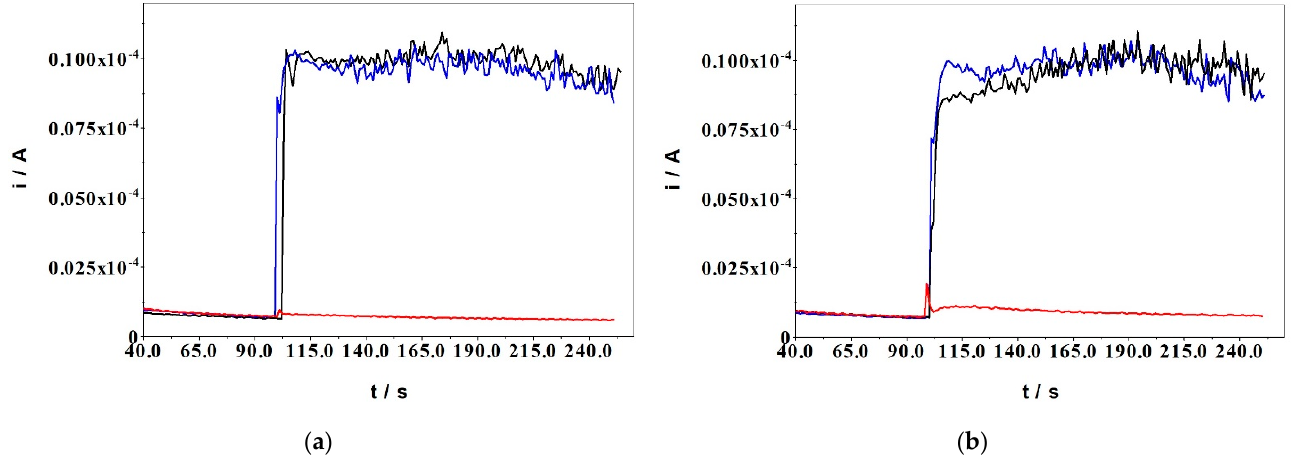
Figure 8. ( a ) Amperometric response for 0.64 mM cholesterol (black line), 0.2 mM Uric acid (red line) and Cholesterol + Uric acid (blue line) added in the mixture (chloroform-TBAP + acetic anhydride + H 2 SO 4 ); ( b ) Amperometric response for 0.64 mM cholesterol (black line), 0.5 mM glucose (red line) and cholesterol + glucose (blue line) added in the mixture (chloroform-TBAP + acetic anhydride + H 2 SO 4 ).